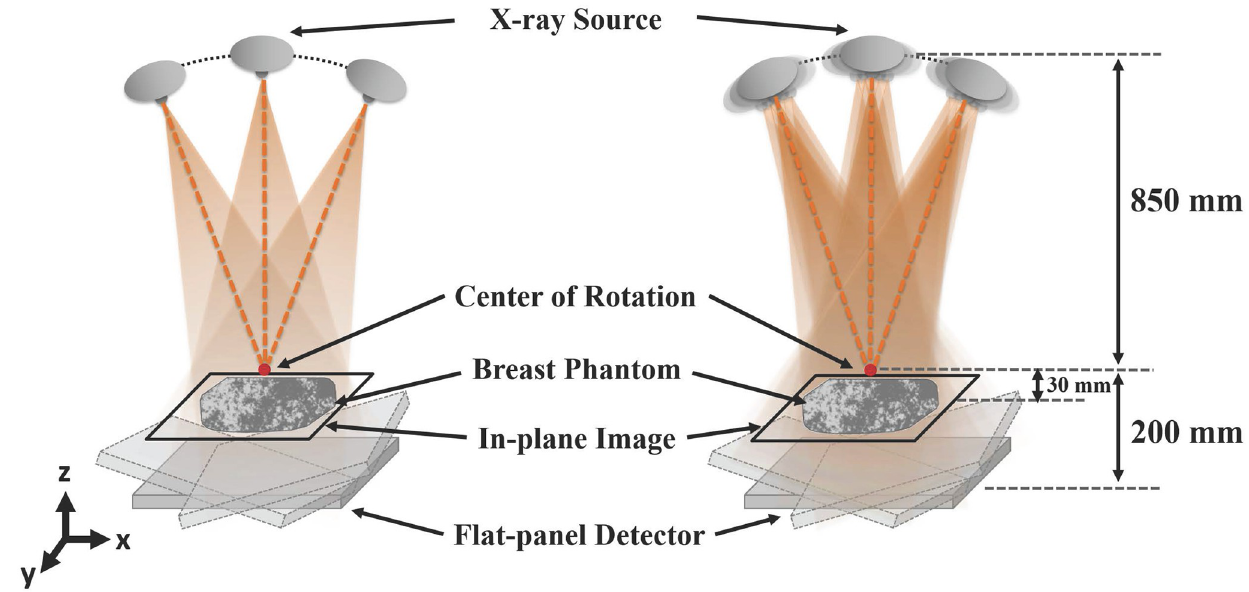
Fig 1. The geometry of digital breast tomosynthesis systems. (a) step-and-shoot mode and (b) continuous mode. The X-ray source and a flat-panel detector rotate simultaneously along the path within a limited angular range.